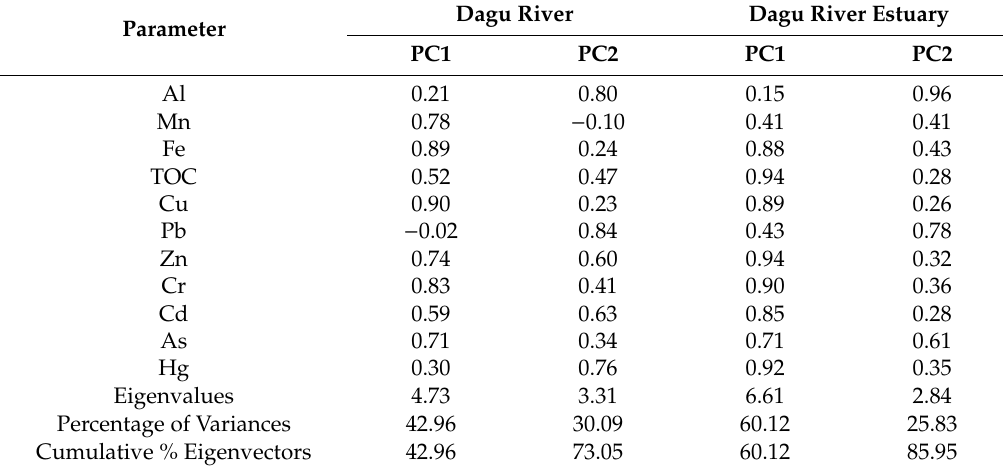
Table 6. Rotated component matrix for data of surface sediments and eigenvalues, percentage of variances, and eigenvectors for the two principal components (PC1–PC2).